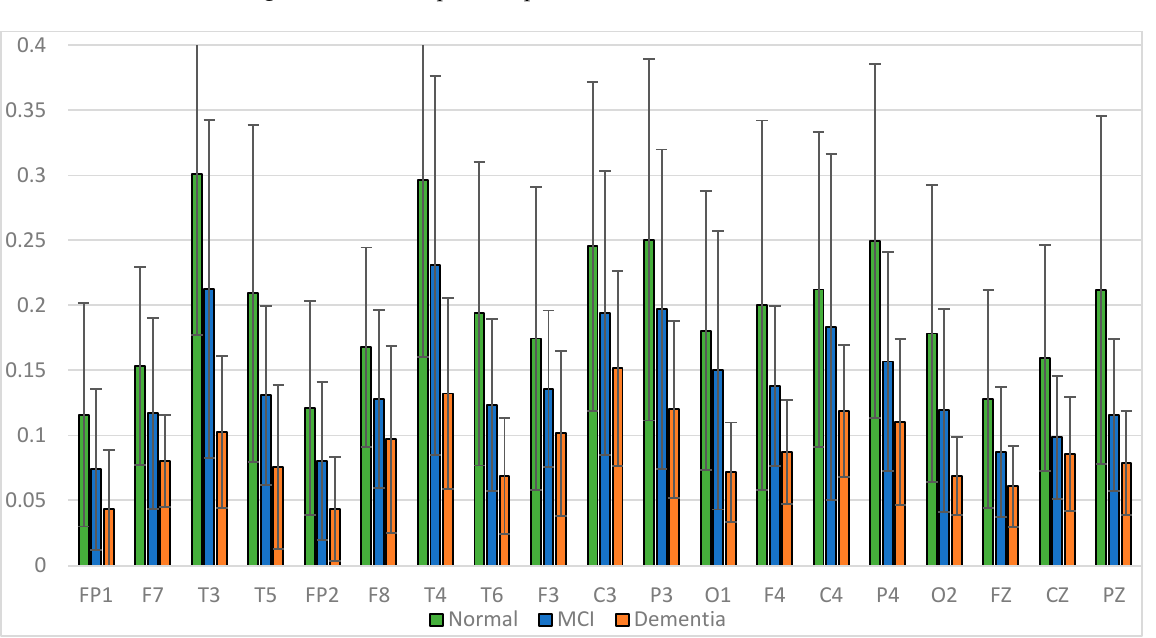
Figure 11. Relative power alpha band.